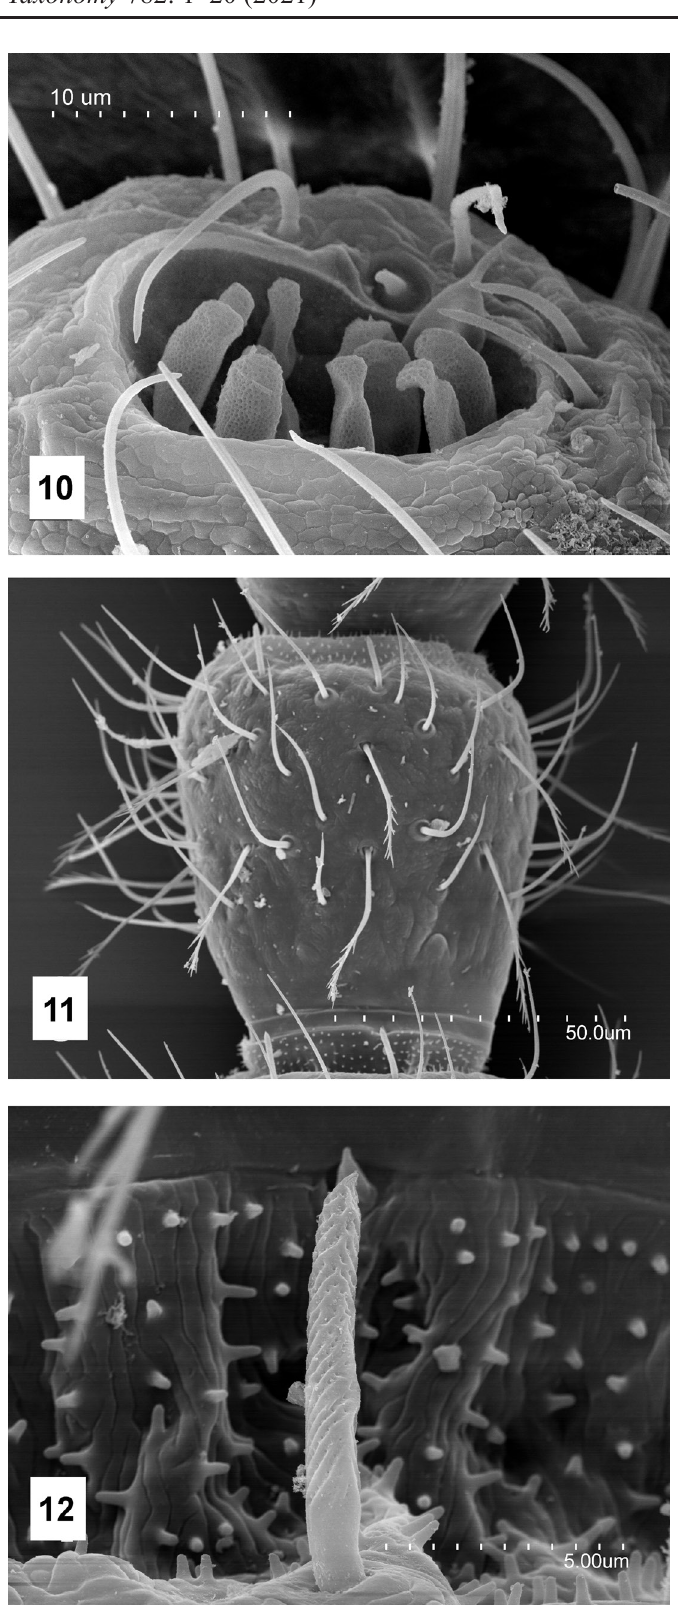
Figs 10−12. Kyrgyzstancampa sanare Sendra & Ferreira gen. et sp. nov., ♂, paratype (Coll. AS). 10 . Cupuliform organ in the last antennomere. 11 . Medial antennomere. 12 . Gouge